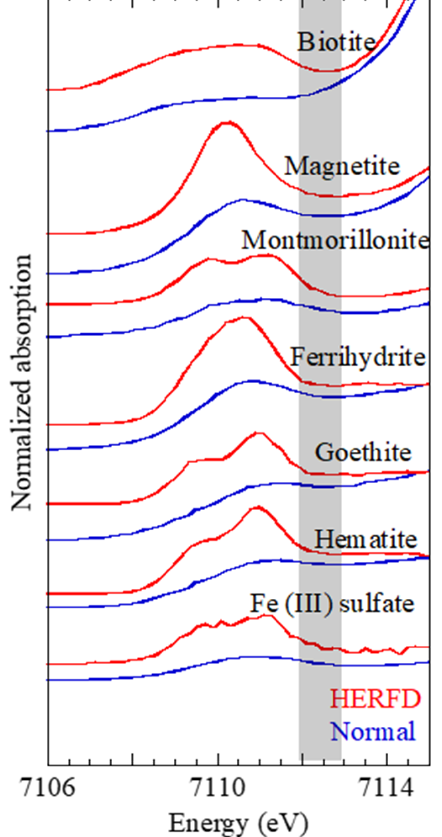
Figure 2. XANES spectra at Fe K-edge for Fe reference materials. Red lines and blue lines show HERFD-XANES and normal XANES spectra, respectively. The gray bar shows the energy where extra components are identified in the normal XANES spectra (7112-7113 keV).